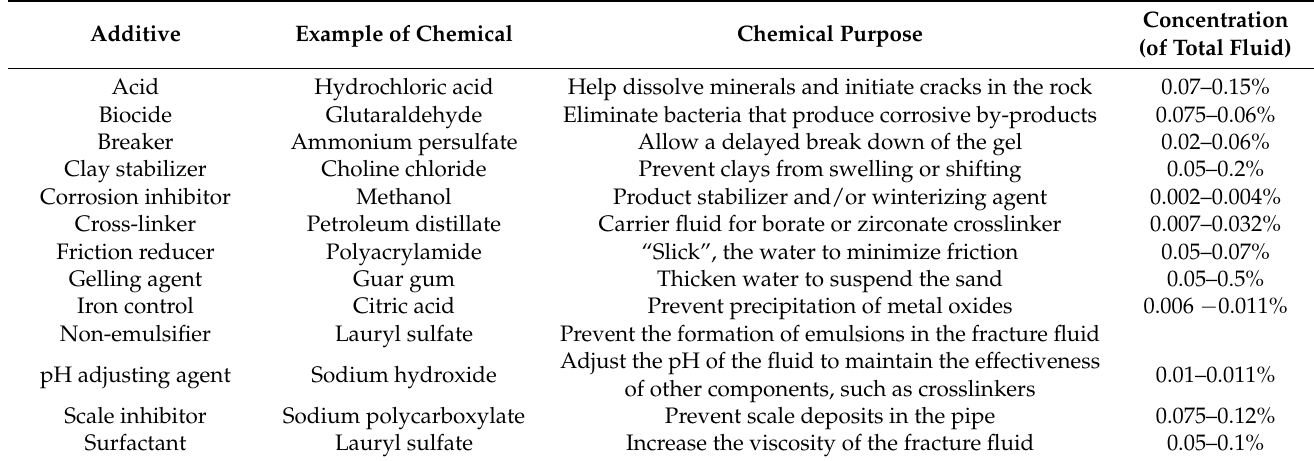
Table 1. Common groups of chemical additives in HF